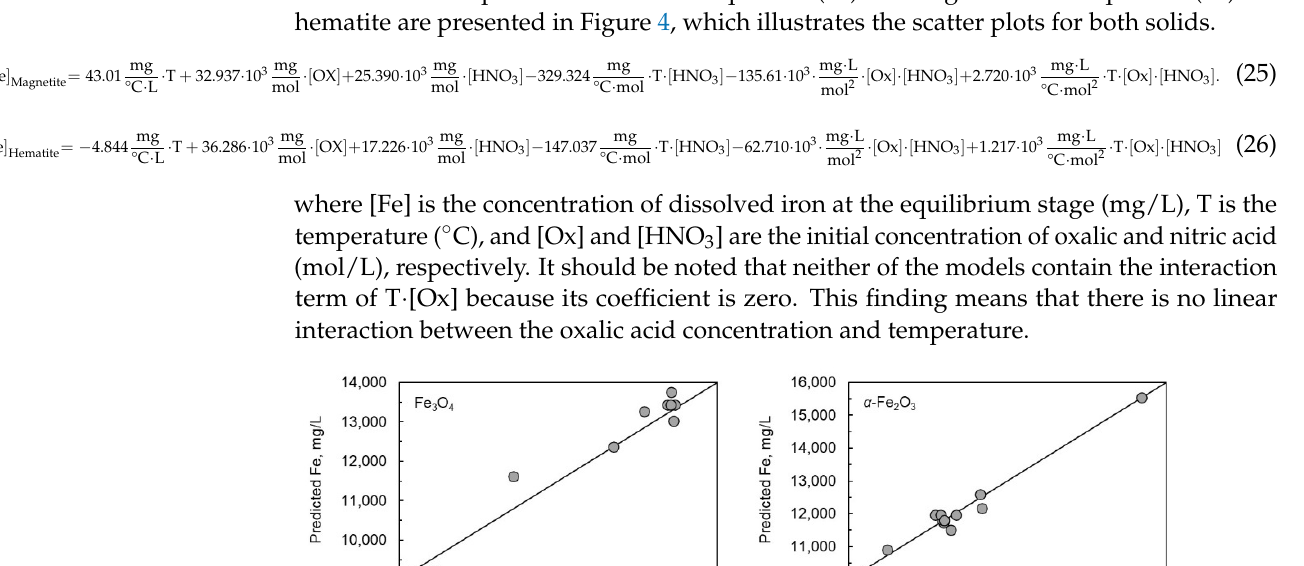
Table 2. p -values of each variable in linear model with interaction